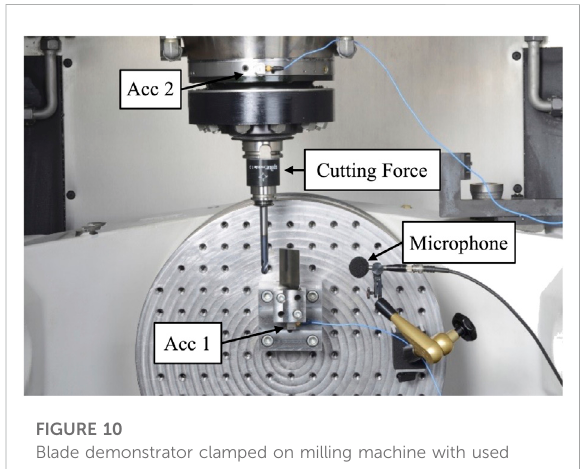
FIGURE 10 Blade demonstrator clamped on milling machine with used